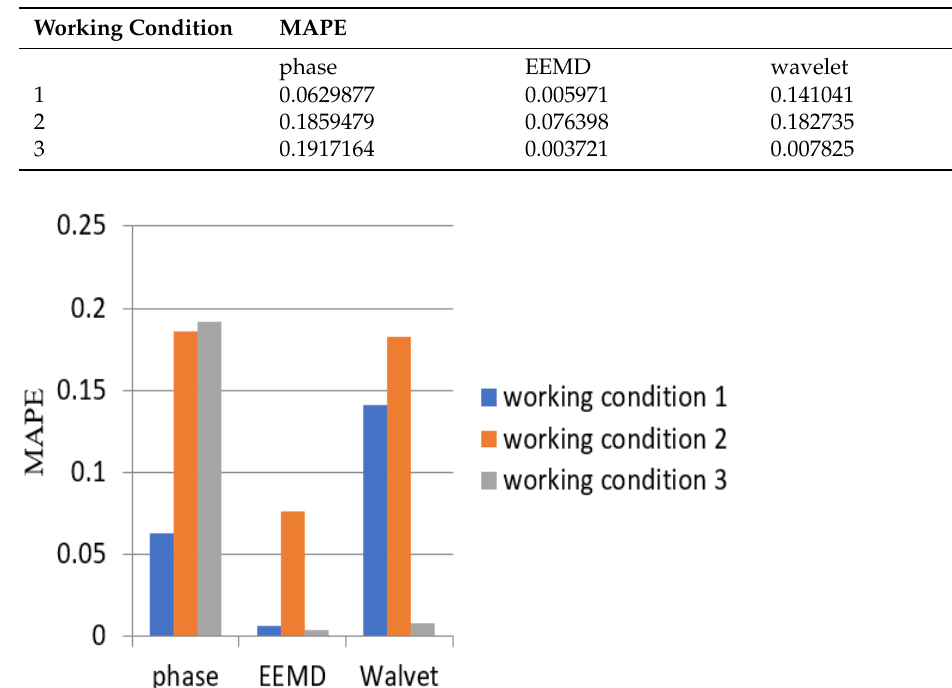
Table 4. MAPE value of different feature spaces.